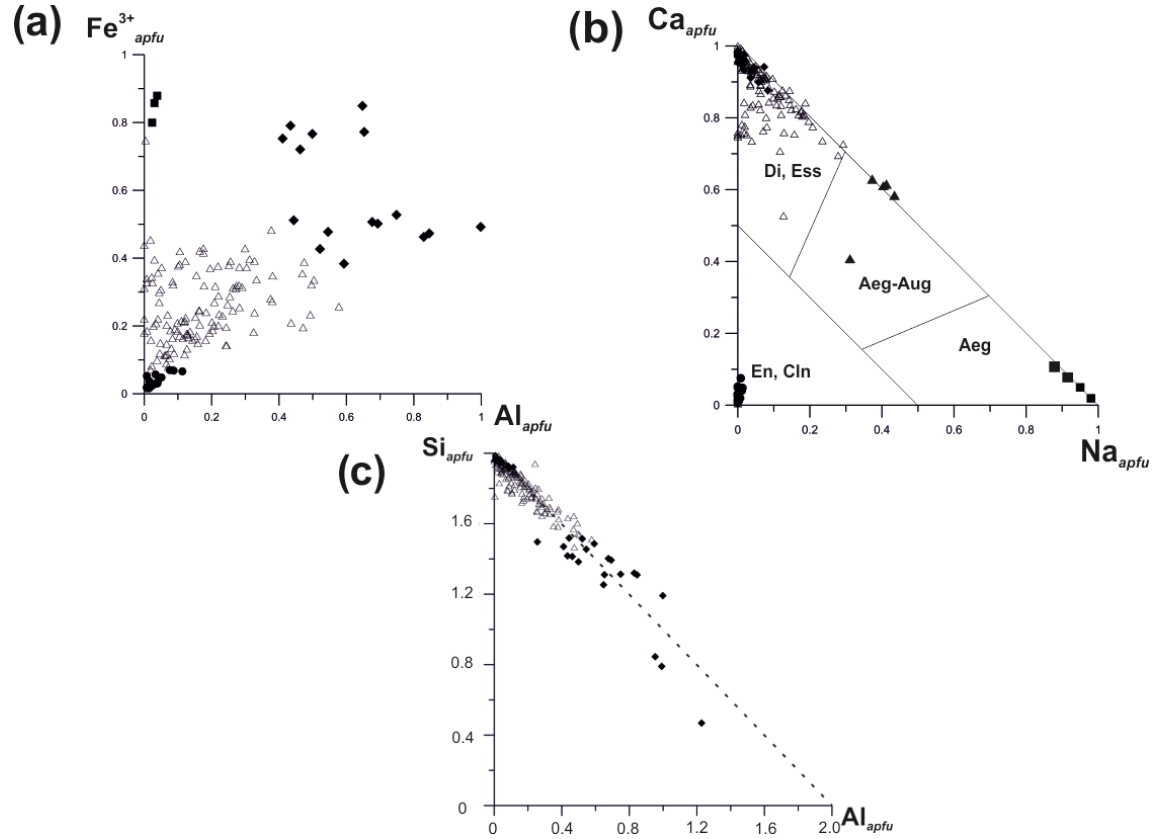
Figure 9. Ratios of Fe 3 + to Al (total, i.e. octahedrally and tetrahedrally coordinated Al) (a) , Ca to Na (b) and Si to Al (total, i.e. both octahedrally and tetrahedrally coordinated Al) (c) in pyroxenes of the diopside (Di)–aegirine (Aeg)–esseneite (Ess) solid–solution system from the Arsenatnaya fumarole: (cid:4) – aegirine, (cid:78) – aegirine-augite, • – enstatite and clinoenstatite, (cid:7) – esseneite, (cid:77) – diopside. The type of diagram (b) was proposed by Morimoto et al.